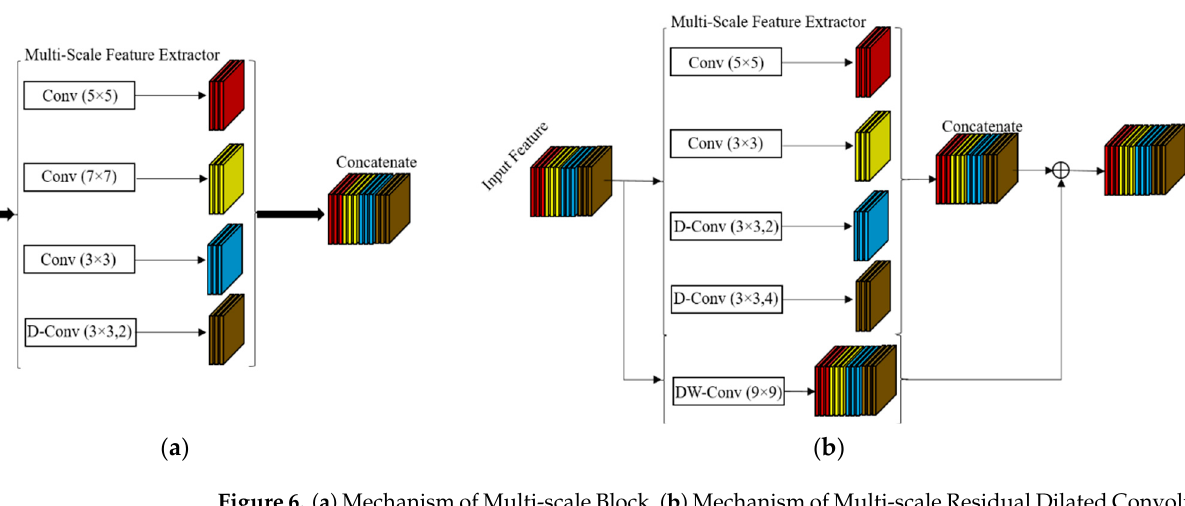
Figure 7. The mechanism of a sample residual block (adapted from Figure 2 in [33]). (2) Multi-scale blocks : The size of buildings on the ground will be affected after an earthquake. Multi-scale blocks, as explained in [34,35], increase the robustness of the network against scale variations. The multi-scale block utilizes some of the 2D-stand- ard convolution layers, while the kernel filter sizes are different.